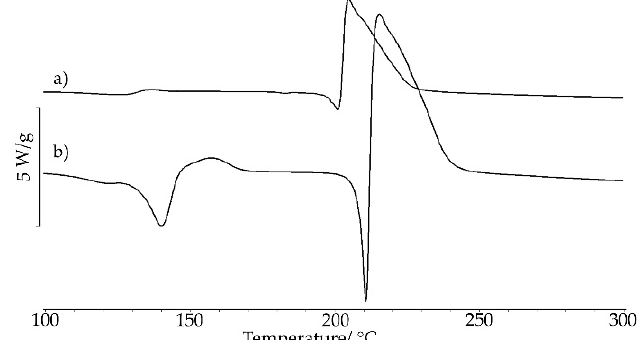
Figure 7. DSC curves for saccharin salt of chlordiazepoxide prepared by the liquid-assisted grinding method. Measurements were taken in nitrogen at a heating rate of ( a ) 10 °C/min and ( b ) 20 °C/min.